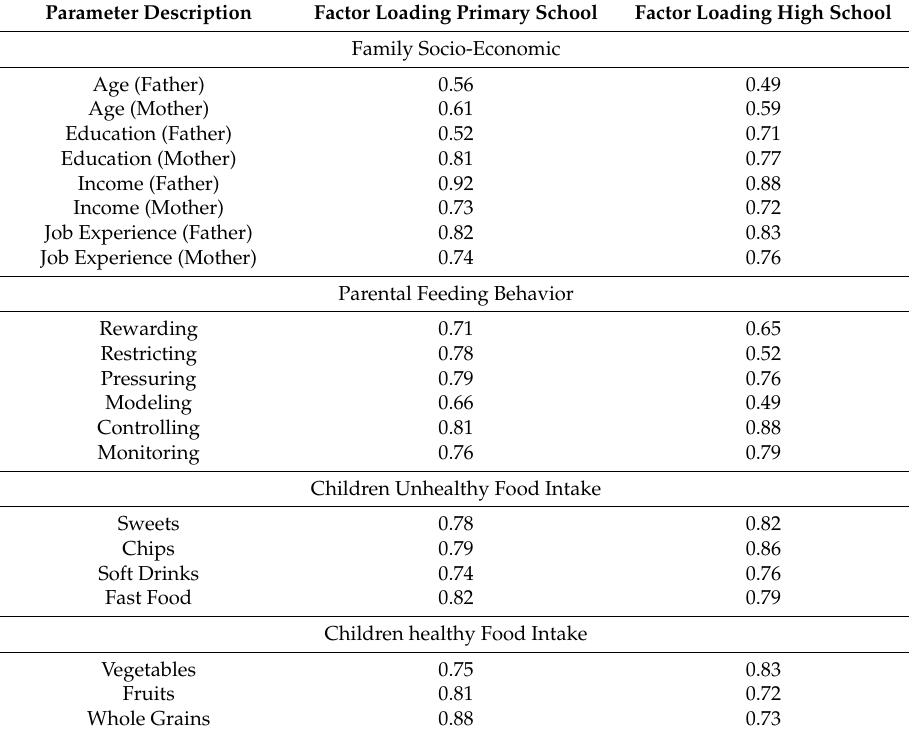
Table 4. Factor loading analysis of the research latent variables.